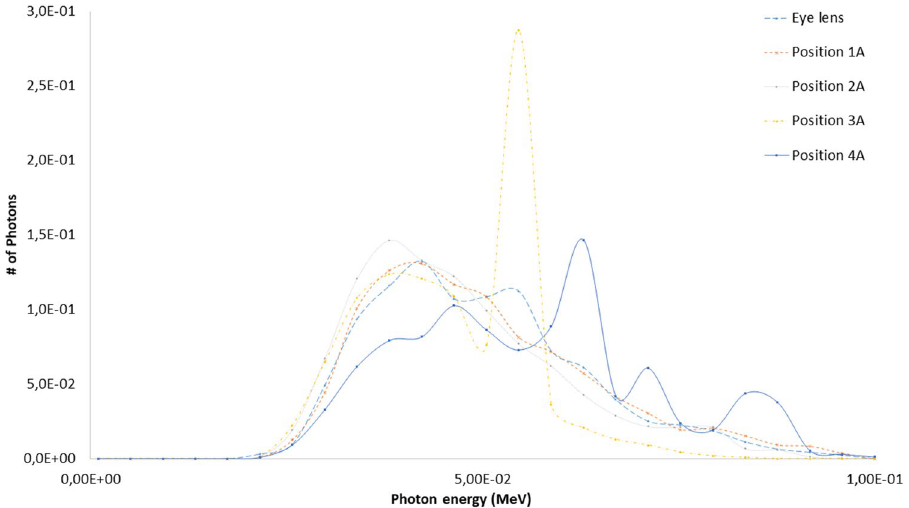
Figure 6. Scenario A. Photon spectra at the detectors (see Fig. 2 for details of position and characteristics) estimated with the MCNP code with the 100 kV endpoint X-ray source (see Fig. 2 for details). Photon energy scale in MeV.